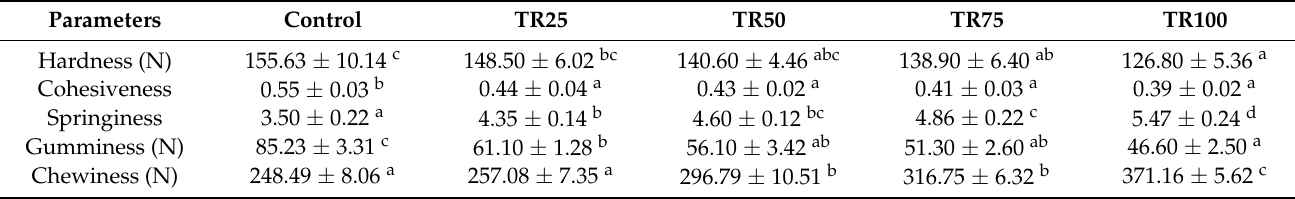
Table 5. Texture profile analysis of sausages with pork fat replaced by